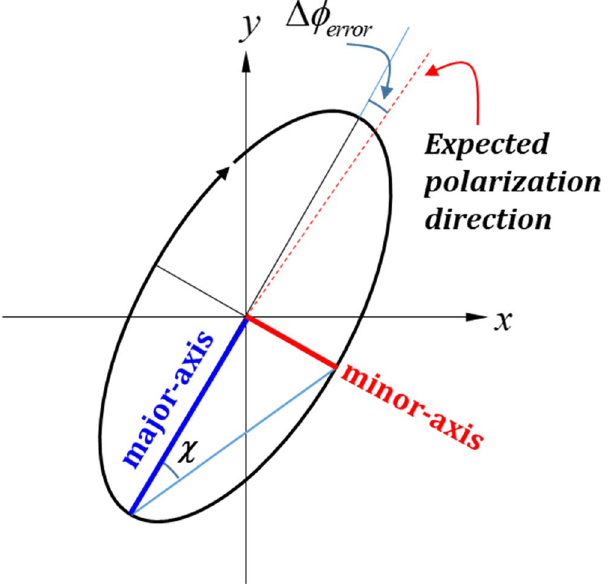
Figure 2. Definitions of two parameters, χ and Δφ error angles, for describing elliptically polarized